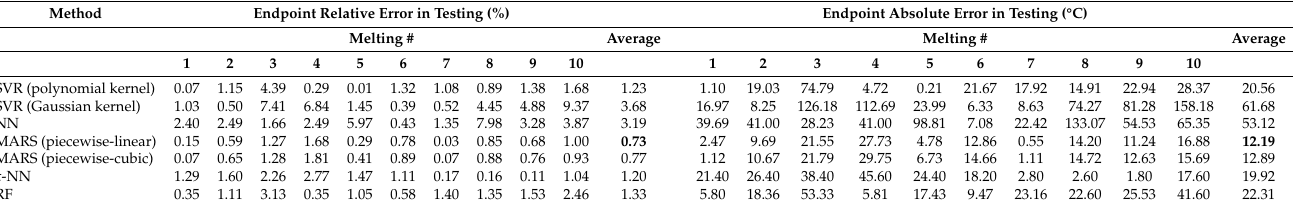
Table 15. Absolute and relative errors in temperature prediction based on dynamic data.